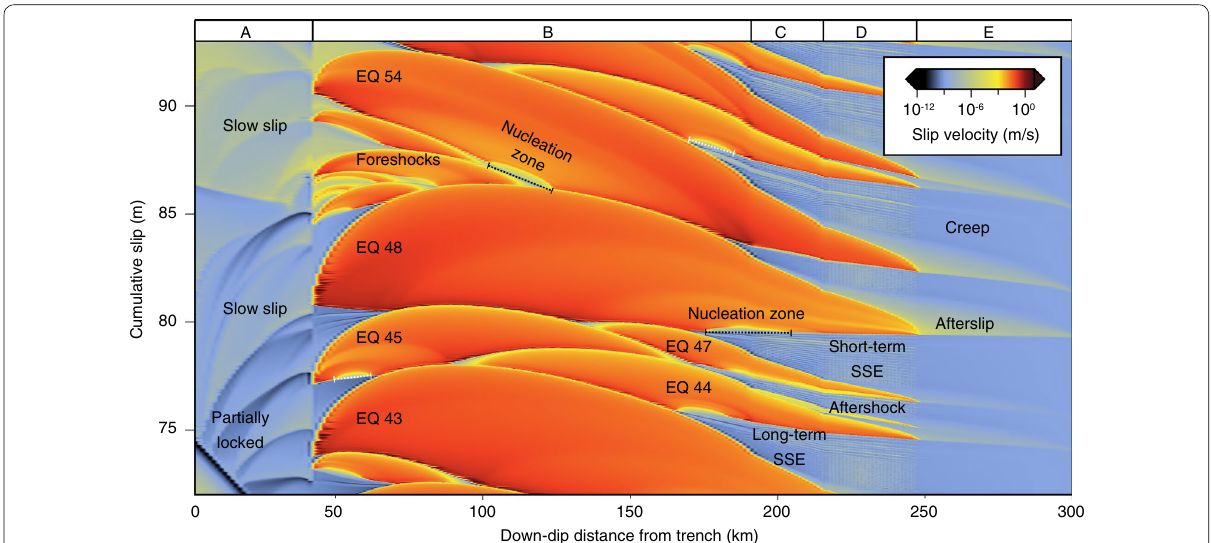
Fig. 6 Partition of slip modes along the megathrust. The accretionary prism (segment A) features partial locking, creep, and occasional slow slip. The seismogenic zone (segment B) shows stick slip with full and partial ruptures, foreshocks and aftershocks, with creep slowly migrating inwards during the interseismic period. Earthquake nucleation (dashed segments) occur up-dip and down-dip the seismogenic zone. Large ruptures can penetrate into the slow-slip segment. Some large ruptures with shallow hypocenters stop before they reach the down-dip boundary of the seismogenic zone, sometimes generating an aftershock in the slow-slip region. Small ruptures occur mostly near the boundaries of the seismogenic zone. The rupture indices are consistent among